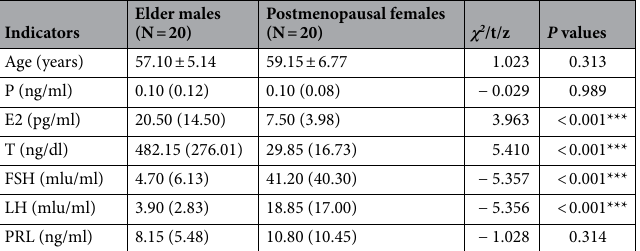
Table 3. Comparison of gonadal hormones between elder males and postmenopausal females. * P < 0.05, ** P < 0.01, *** P < 0.001.